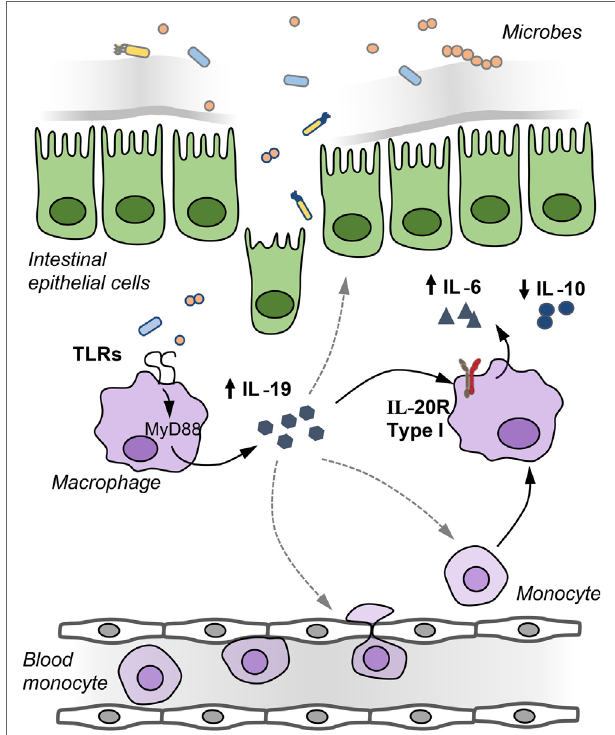
FigURe 2 | IL-19 regulates IL-6 production by macrophages in an autocrine manner. After barrier disruption, microbes or microbial-derived products invade the host to activate underlying monocytes and macrophages in the lamina propria to induce IL-19 production. IL-19 regulates in an autocrine manner the production of IL-6 by macrophages, IL-19 may recruit monocytes and macrophages to the inflamed gut, and IL-19 may affect the integrity of the intestinal epithelial